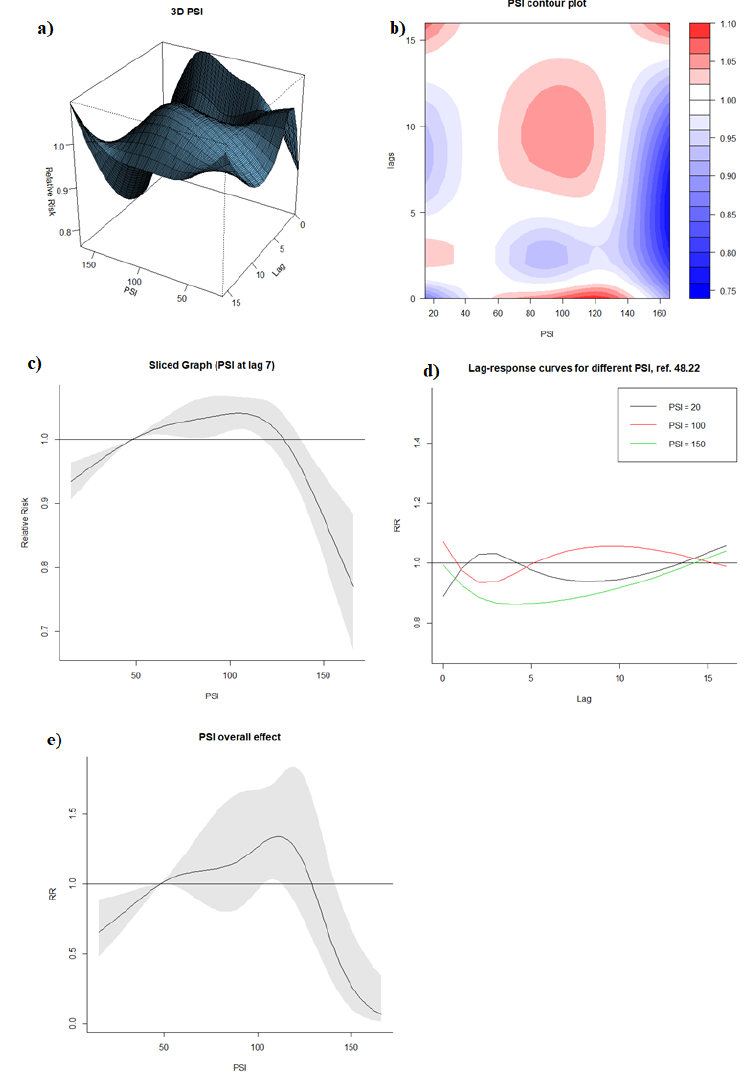
Figure 3. ( a ) 3D graph of PSI-lag-dengue association; ( b ) contour graph of PSI-lag-dengue association; ( c ) sliced graph of PSI-dengue association at lag 7; ( d ) sliced graph of Lag-response association at PSI level of 20, 100, 150; ( e ) overall effect graph of PSI-dengue association.